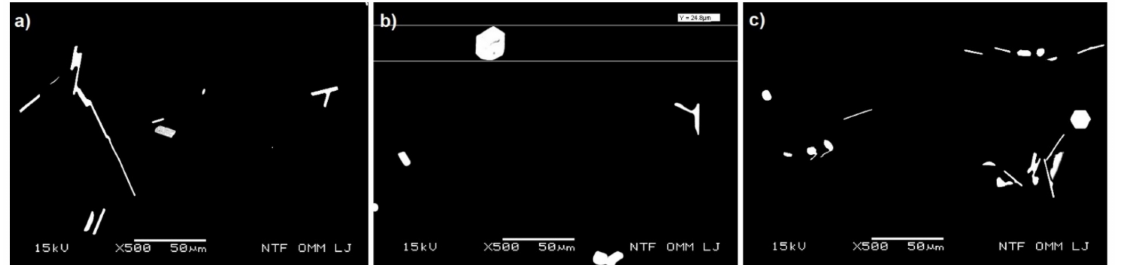
Figure 6. Plate, angular, and hexagonal Mg 3 Bi 2 phases (bright areas) ( a ) 1M150, ( b ) 2M150 (c) 3M105 (BEI-higher